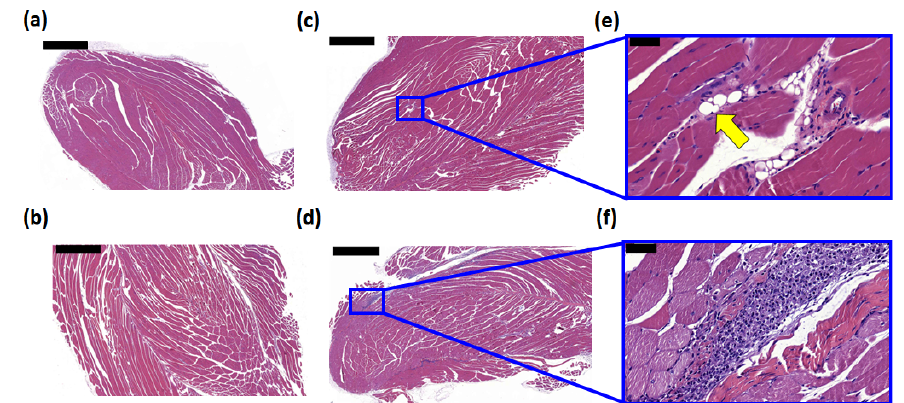
Figure 4. Histological analysis of the injection site in the quadriceps muscles. C57BL/6 mice were immunized with 100 µ L of ( a ) 10 mM sodium citrate solution, pH = 6.5, ( b ) OVA 50 µ g, ( c , e ) OVA 50 µ g with SQ@HACH, and ( d , f ) OVA 50 µ g with AlPO 4 (aluminum content 30 µ g) at quadriceps. The quadriceps muscle tissues were removed on day 14 and stained by H&E staining. The muscle sections were observed by microscopy at magnification (10 × and 40 × ). Scale bar: 1000 µ m ( a – d ) and 50 µ m ( e , f ). The yellow arrow indicates the vesicles of